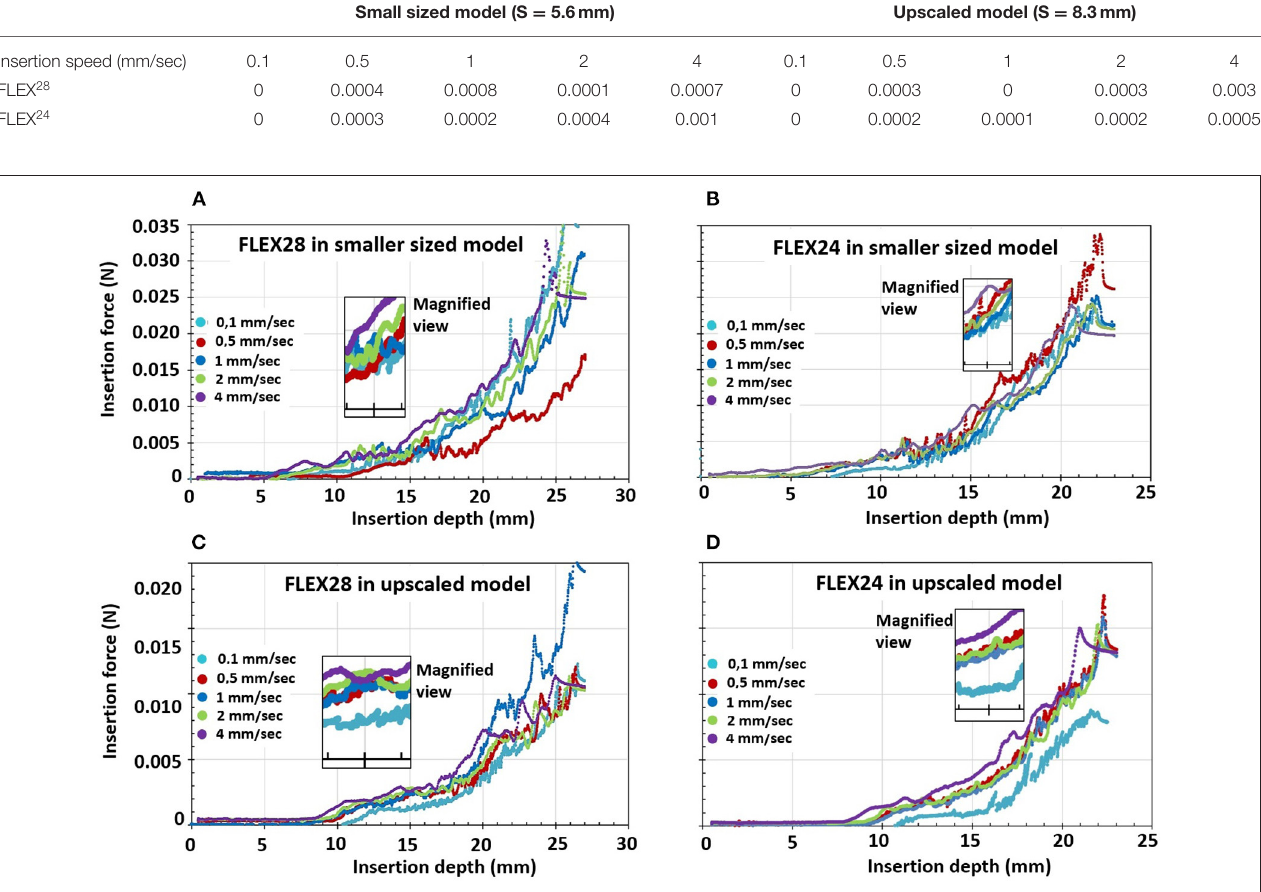
FIGURE 6 | Electrode insertion force measurement of FLEX28 and FLEX24 electrodes in two different sized cochlear model applying five different insertion speeds of 0.1, 0.5, 1, 2, and 4 mm/s. (A) FLEX28 and (B) FLEX24 in the average sized cochlea model. (C) FLEX28 and (D) FLEX24 in the upscaled model. The inner magnified view shows the insertion force curves for various insertion speeds at 15mm of insertion depth. The purple curve corresponds to the highest insertion speed of 4 mm/s showing higher insertion forces and the turquoise curve corresponds to the lowest insertion speed of 0.1 mm/s showing lower insertion